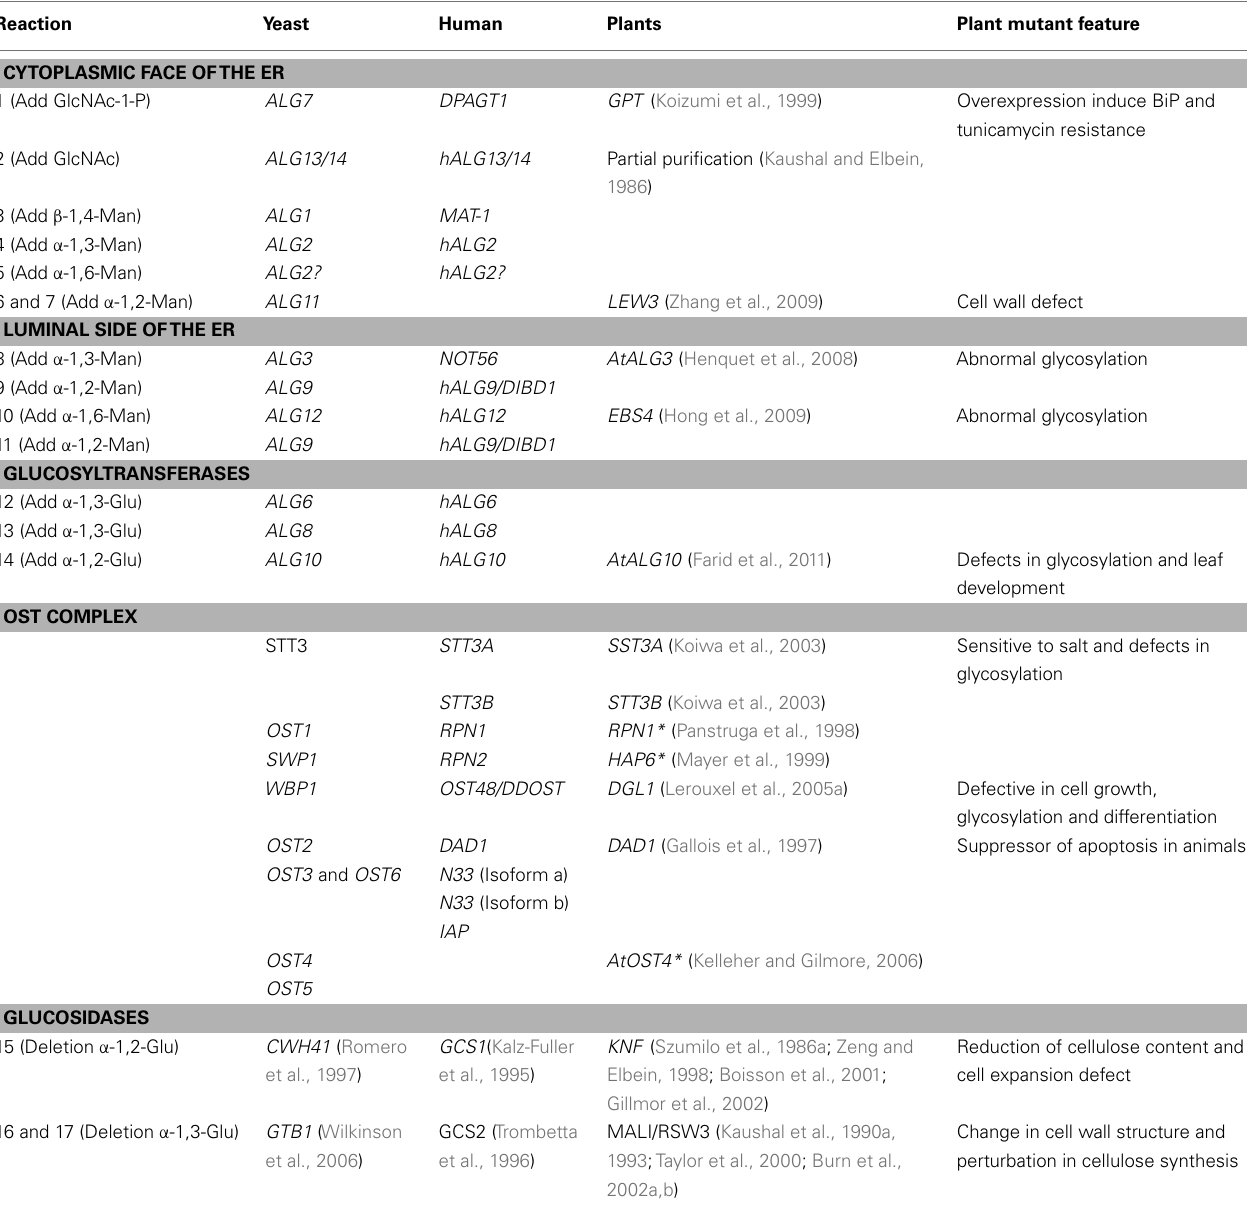
Table 1 | Homologous yeast, human and plants genes associated with N -glycosylation and phenotypes of related plant mutants. Reaction Yeast Human Plants Plant mutant